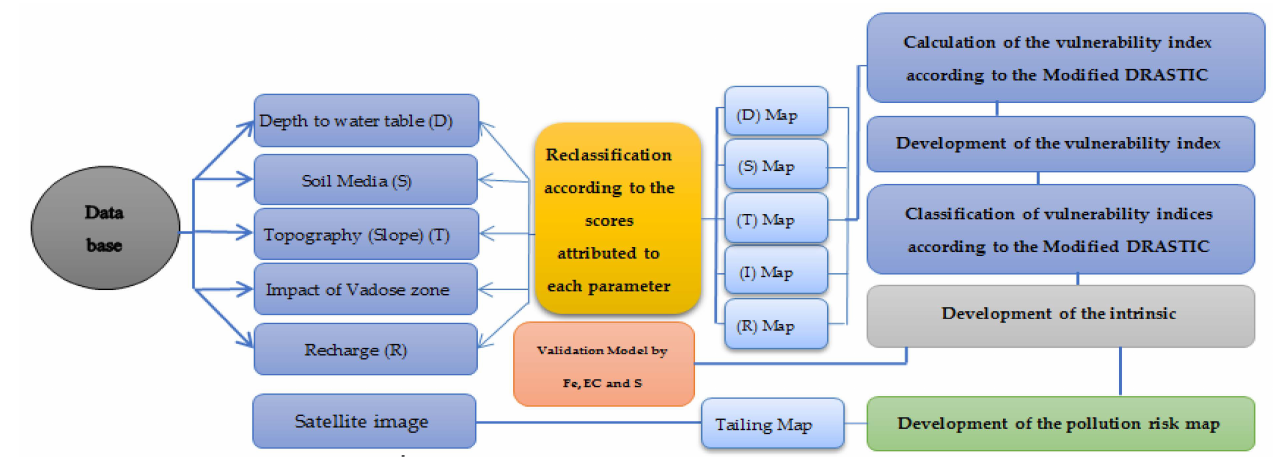
Figure 4. Flow chart of the applied methodology from this study. The same weights, scores, and classes as those defined by DRASTIC method are assigned to the five parameters used on the new “DRSTI” index. The new vulnerability index (Vi) is calculated according to Equation (2) and Table 1: